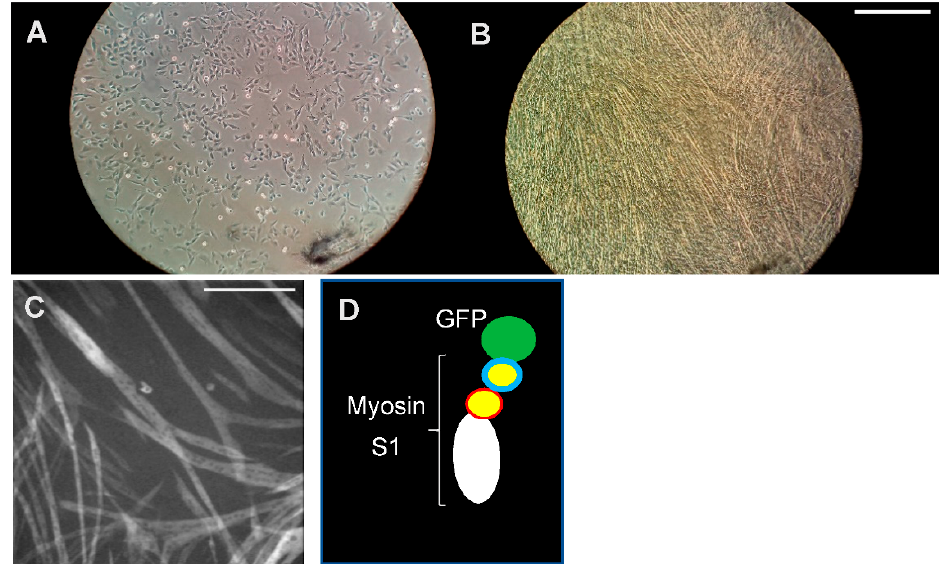
Figure 3. Myosin expression. Cardiac myosin heavy chain ( β -MHC) needs to be expressed in mammalian muscle cells for correct folding and full activity. ( A ) Mouse myoblasts (C2C12) seeded in a well of a multi-well plastic plate. ( B ) The cell culture well after 7 days of differentiation of the cells into elongated myotubes in which fully functional myosin motor domains can be produced. Scale bar: 1 mm. ( C ) Expression of myosin S1 motor fragments by myotubes as reported by the GFP-tag fluorescence. Scale bar: 0.5 mm. ( D ) Schematic illustration of expressed S1-GFP construct.